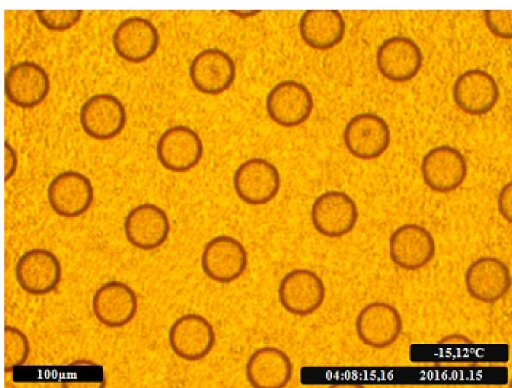
Figure 3. Screenshot of the freezing chip from a recorded freezing video. Cavities ( d = 40 µ m) are filled with liquid ultrapure water and covered with oil. Temperature, date, and time is automatically